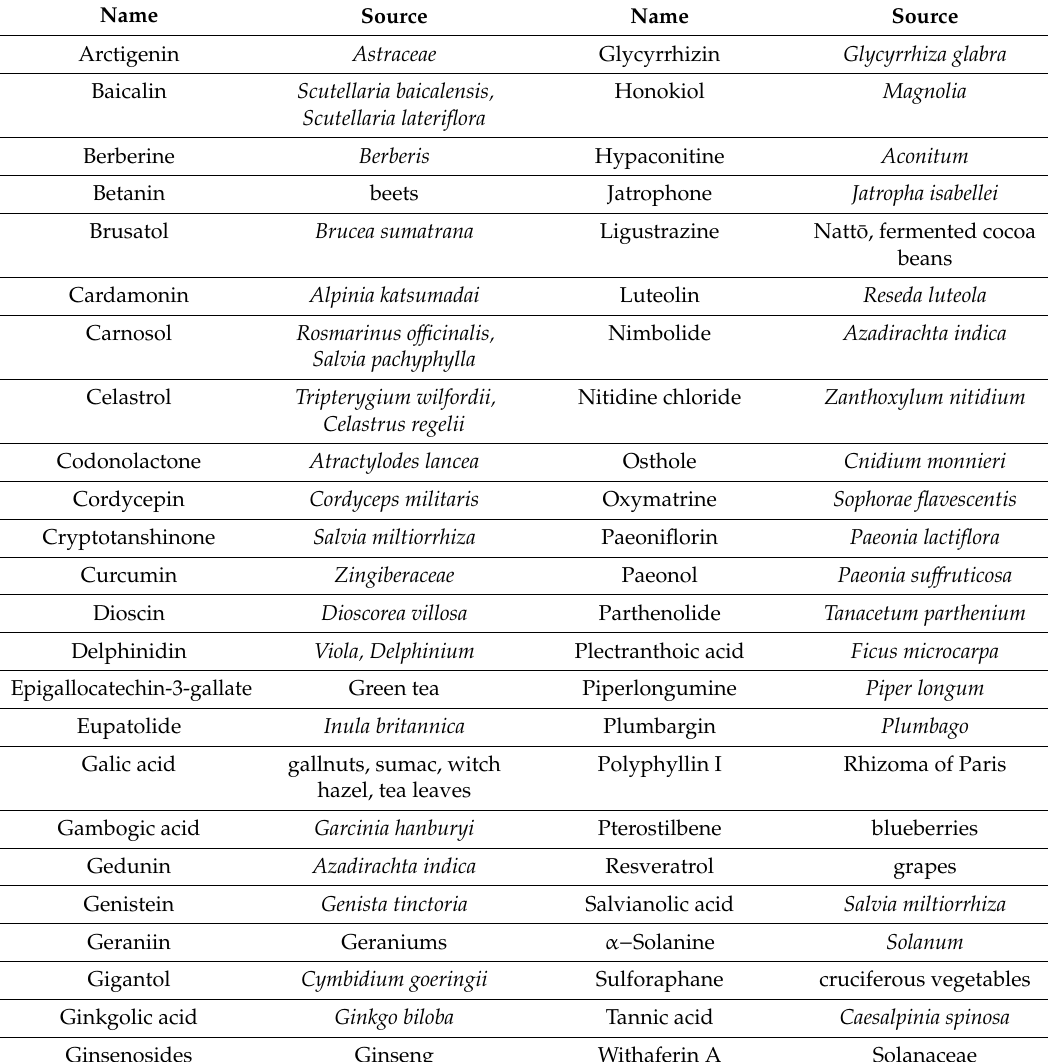
Table 1. Lists of EMT inhibitors from natural